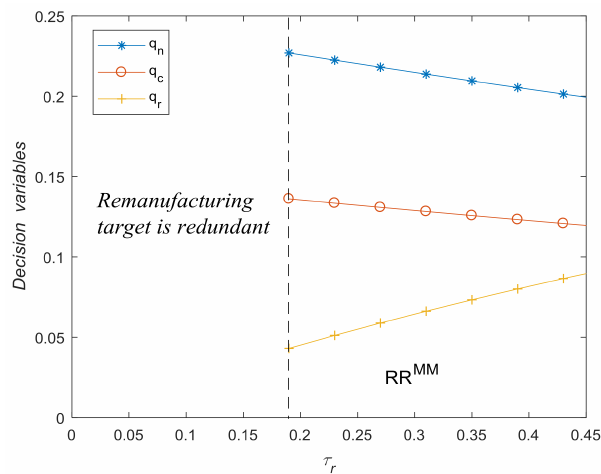
Figure 7. The impact of τ r on optimal decisions.